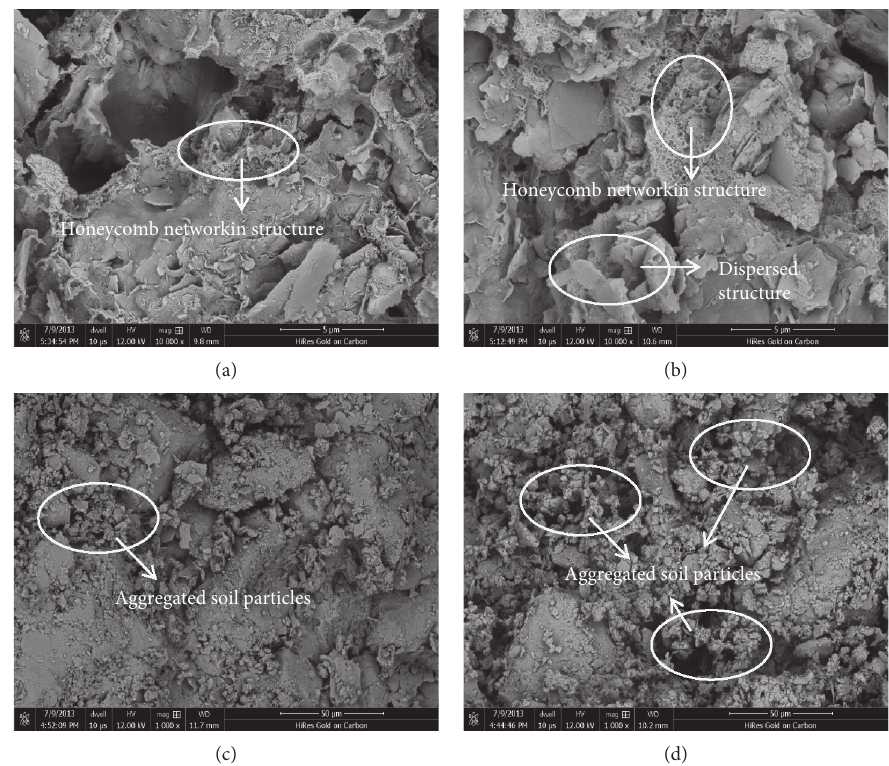
Figure 10: SEM images of lime-stabilized specimens with RAL of 10% under different W-D cycles: (a) 0 W-D cycle; (b) 1 W-D cycle; (c) 5 W-D cycles; (d) 20 W-D